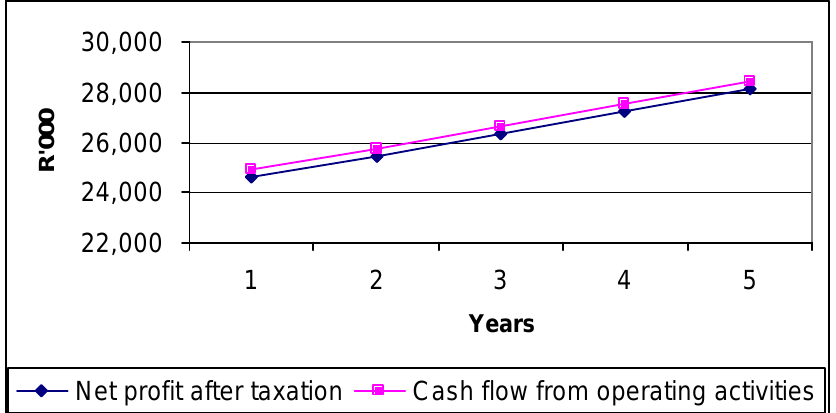
Figure 3: A high growth rate, high non-cash working capital and a low net profit ratio